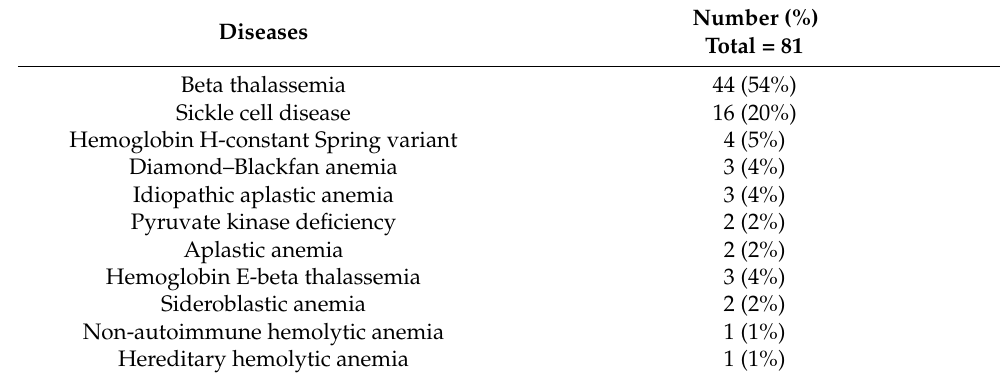
Table 2. Table representing the type of disorder associated with the patients referred for clinical MR liver